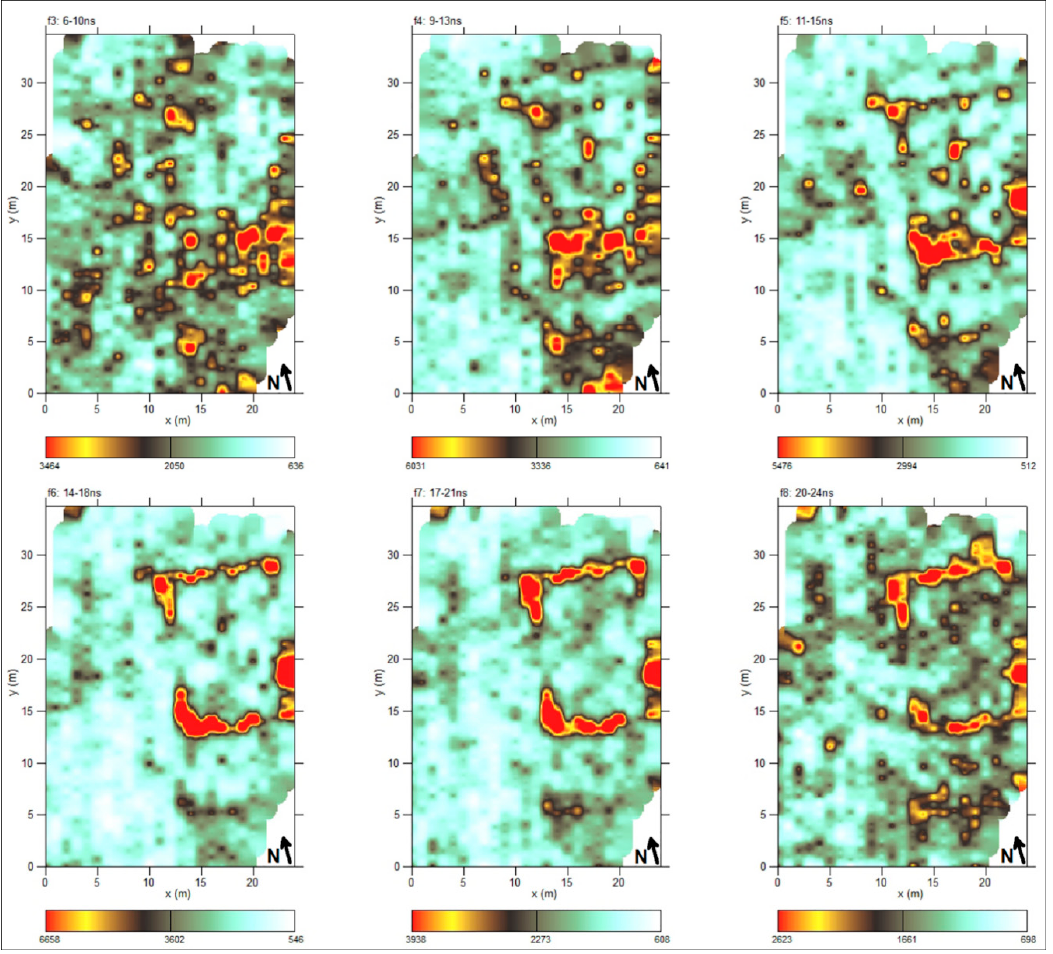
Figure 7. Doclea: a selection of time slices relative to the southern part of the private house (1 in Figure 10). The colour scale indicates the measured variation of the amplitude of the electromagnetic signal.